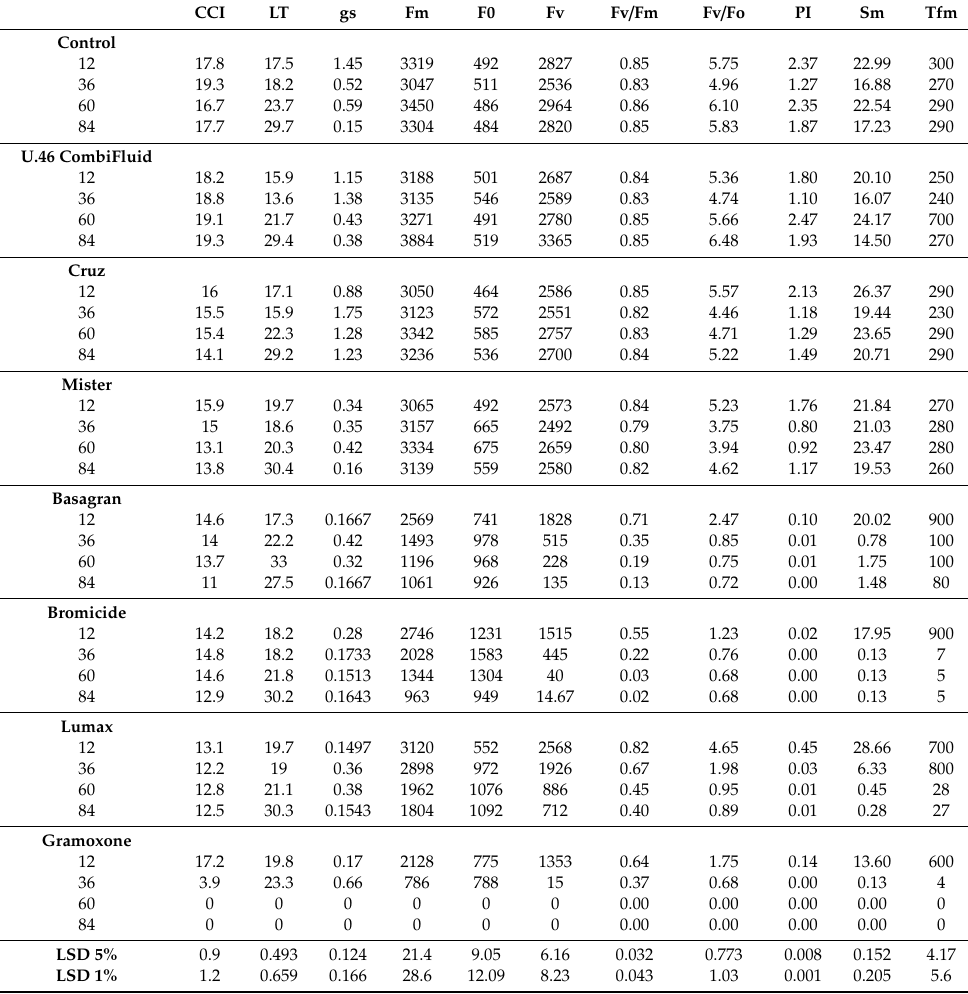
Table 1. Changes in chlorophyll content index (CCI), leaf temperature (LT), stomatal conductance ( g s ), minimal fluorescence (Fo), maximal fluorescence (Fm), variable fluorescence (Fv), water-splitting complex on the donor site of the PSII (Fv / Fo), maximum quantum yield of PSII (Fv / Fm), photosynthesis relative vitality (PI), Q A reduction rate of the PSII acceptor (Tfm), and energy necessary for the closure of all the reaction centers (Sm) in response to di ff erent herbicides. Data are presented as mean from at least three sets of di ff erent measurements (least significant di ff erences (LSD 5% and 1%) of means mentioned below the